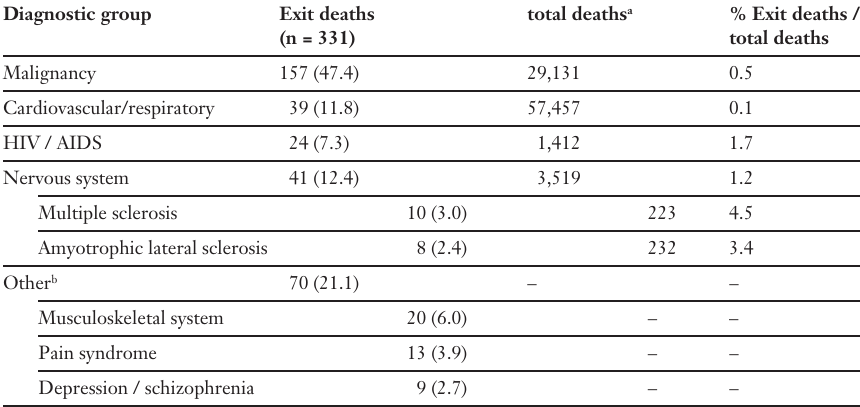
Medical diagnoses in Exit deaths and total deaths among resi- dents of Canton Zurich between 1990 and 2000. Figures are numbers (column percentage) of